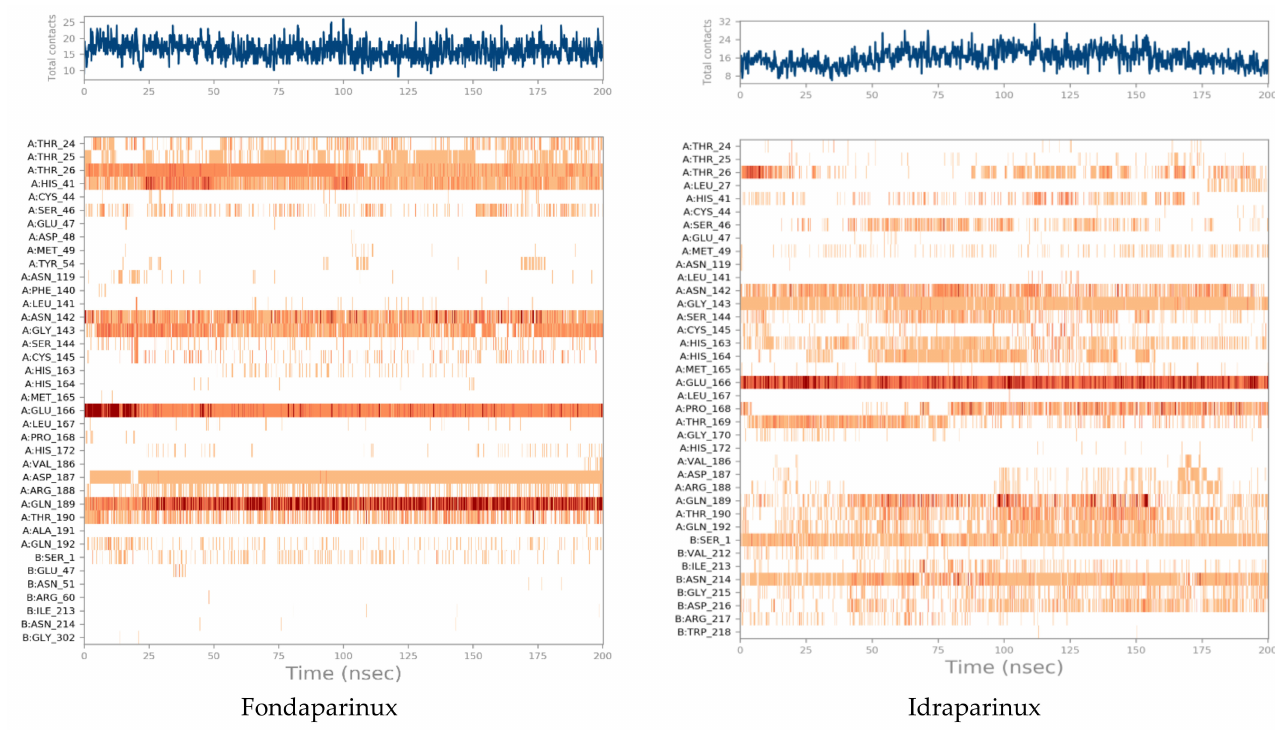
Figure 8. Heat map describing the total number of interactions within M pro pocket during the 200 ns.